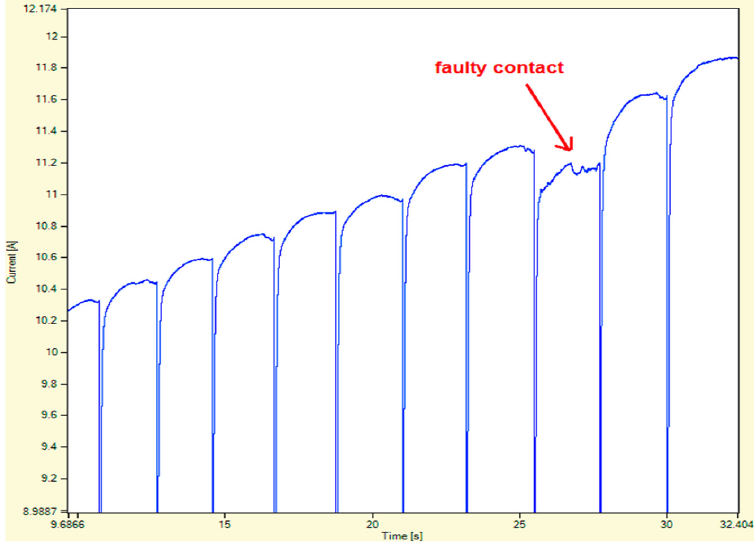
Figure 13. Example of an abnormality of the Dvtest graph linearity [51].